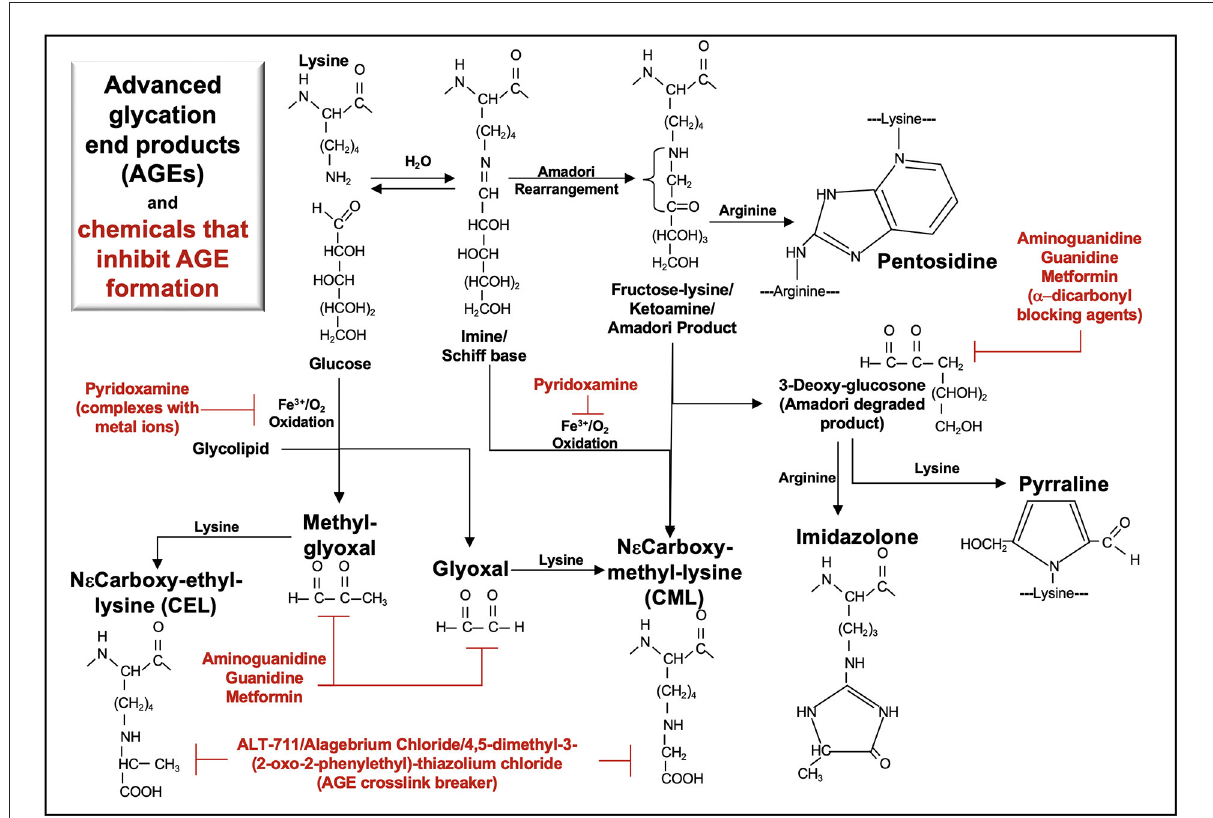
FIGURE2 Metabolic pathways of selected AGE and their inhibitors . Advanced glycation end-products (AGE) are formed via non-enzymatic glycosylation of proteins. Glycation initially occurs when the aldehyde or ketone groups of reducing sugars react reversibly with an amino group as found in lysine, forming a Schiff base. Rearrangement of the Schiff base yields a more stable ketoamine (Amadori product), in which the free carbonyl may react with an arginine free amino group to form pentosidine. Oxidation of glycolipids, glucose, Schiff base or Amadori products yields highly reactive carbonyl intermediates (e.g., glyoxal, methyl-glyoxal, 3-deoxy-glucosone) that react with a free amino group, forming various AGEs (CEL, CML, pentosidine, pyrraline, imidazolone). Aminoguanidine, guanidine, metformin, pyridoxamine, and ALT-711 inhibit AGE